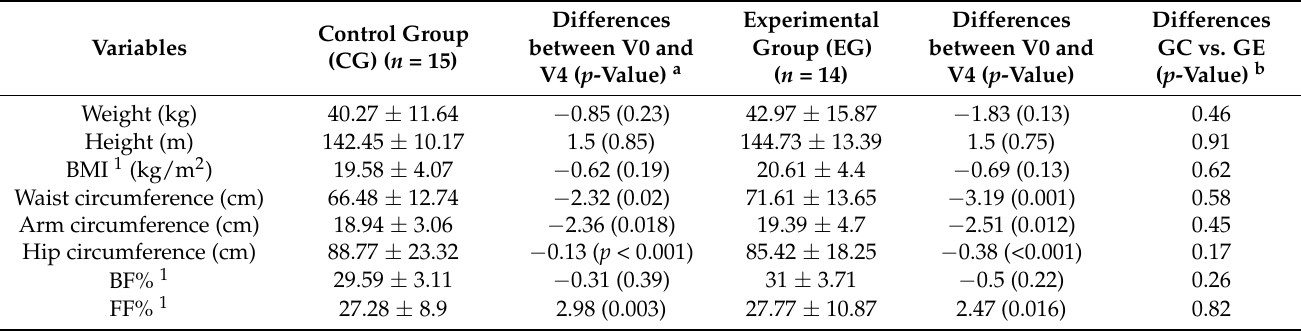
Table 2. According to the randomization group, values after the nutritional intervention of 29 children with